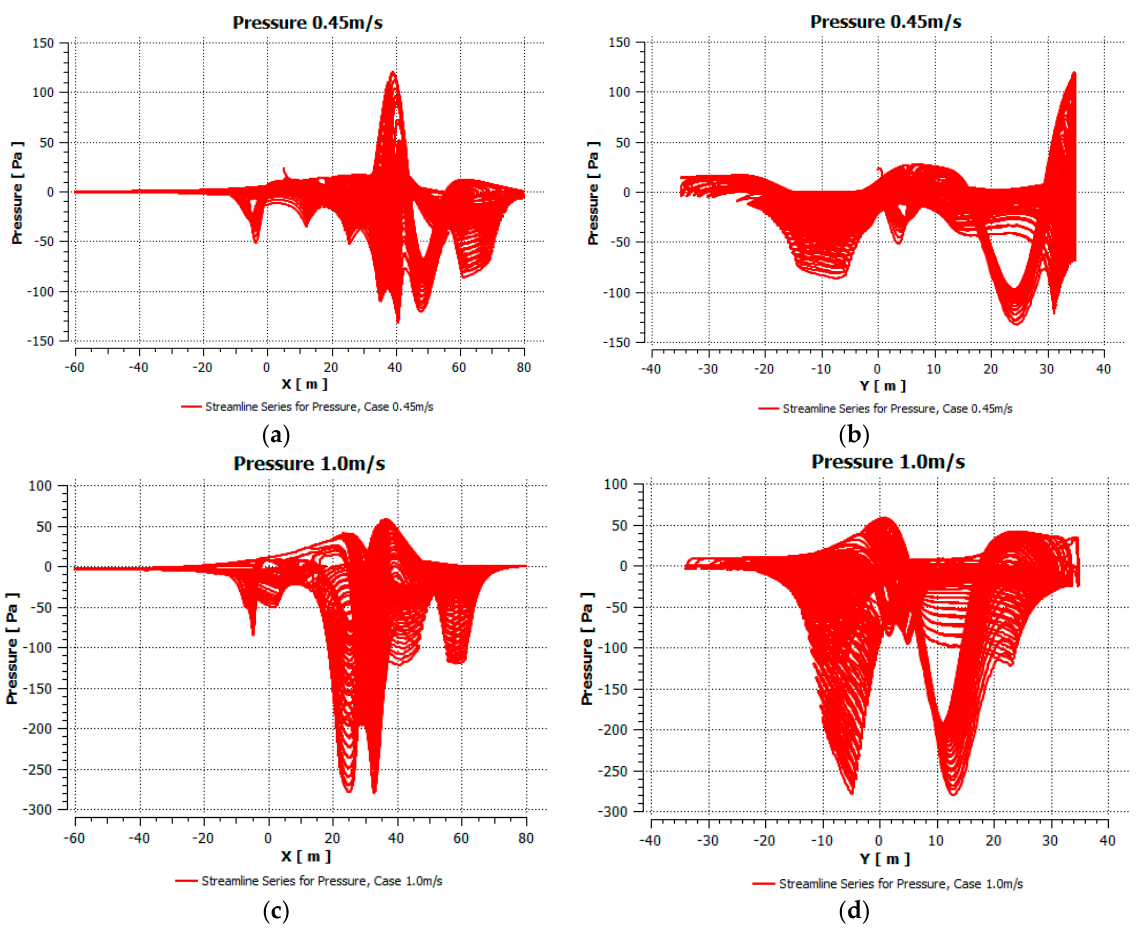
Figure 21. Pressure profile for the flow on the buoy showing the streamline series: ( a , b ) Streamline series for Pressure, case 0.45 m/s; ( c , d ) Streamline series for Pressure, case 1.0 m/s.